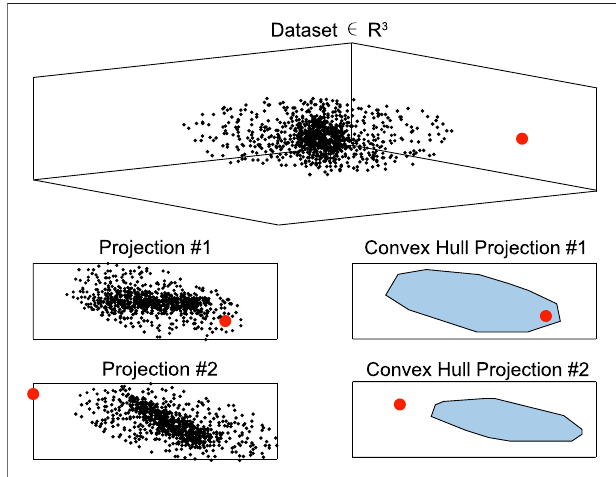
FIGURE 6 | An example of the convex hull for less over fi tting.